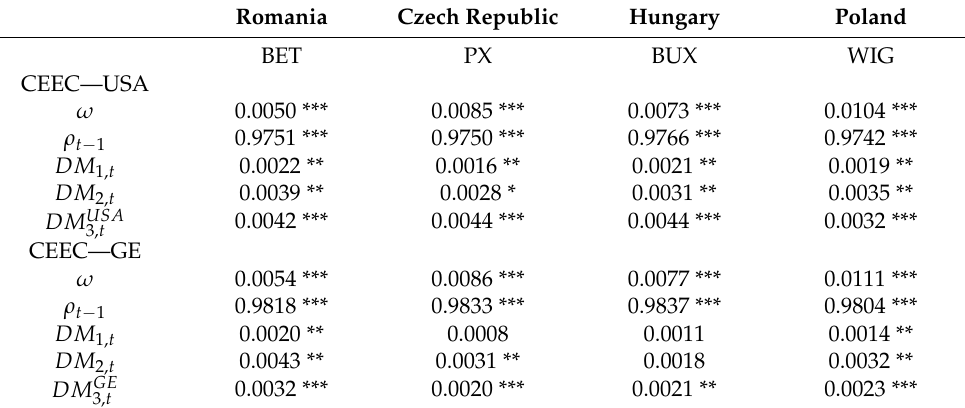
Table 5. Dynamic conditional correlation coefficients during periods of